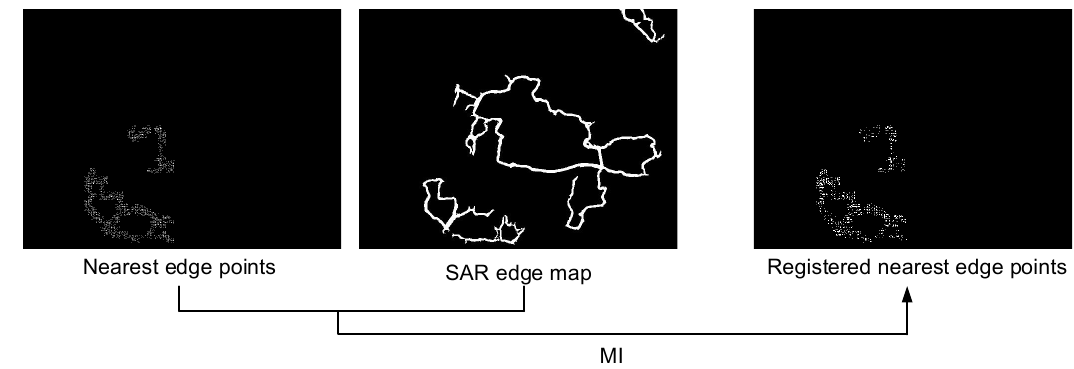
Figure 4. Mutual information registration in the fine registration